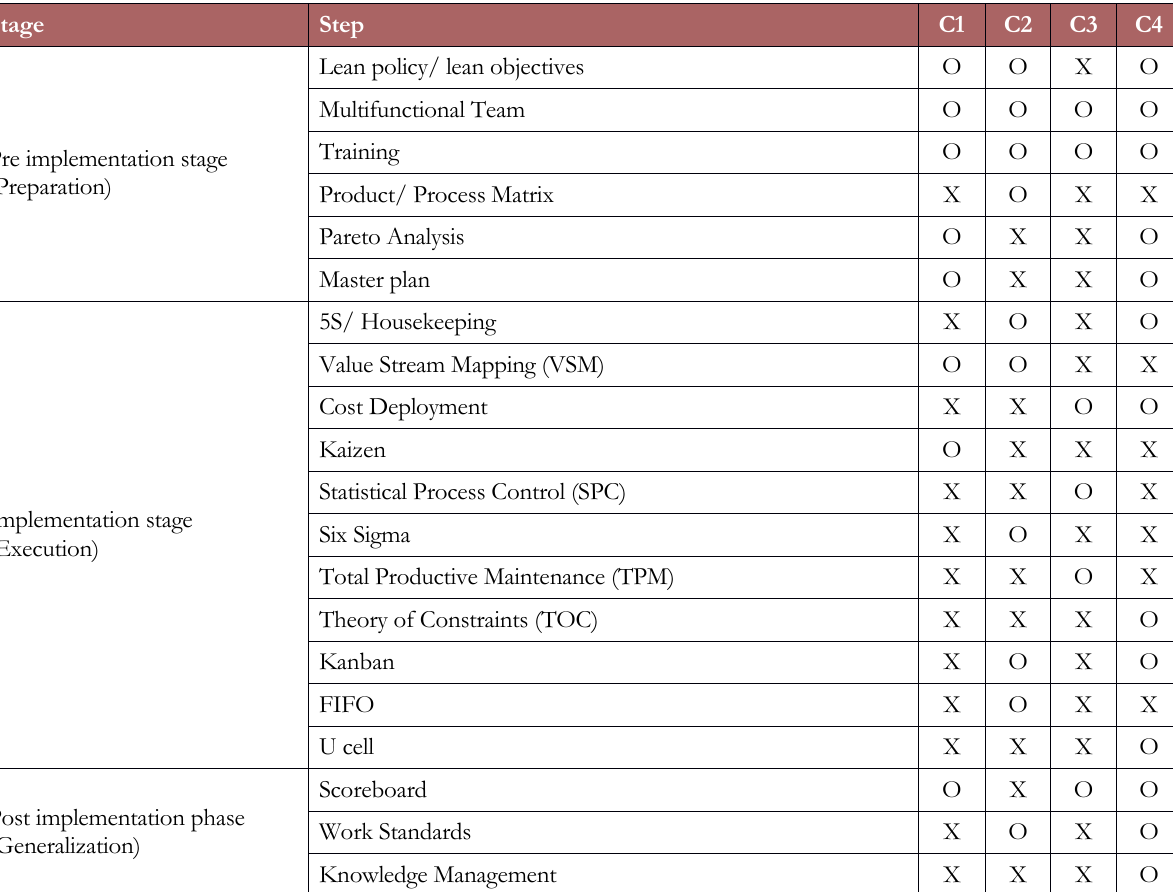
Table 4. Lean tools implemented in